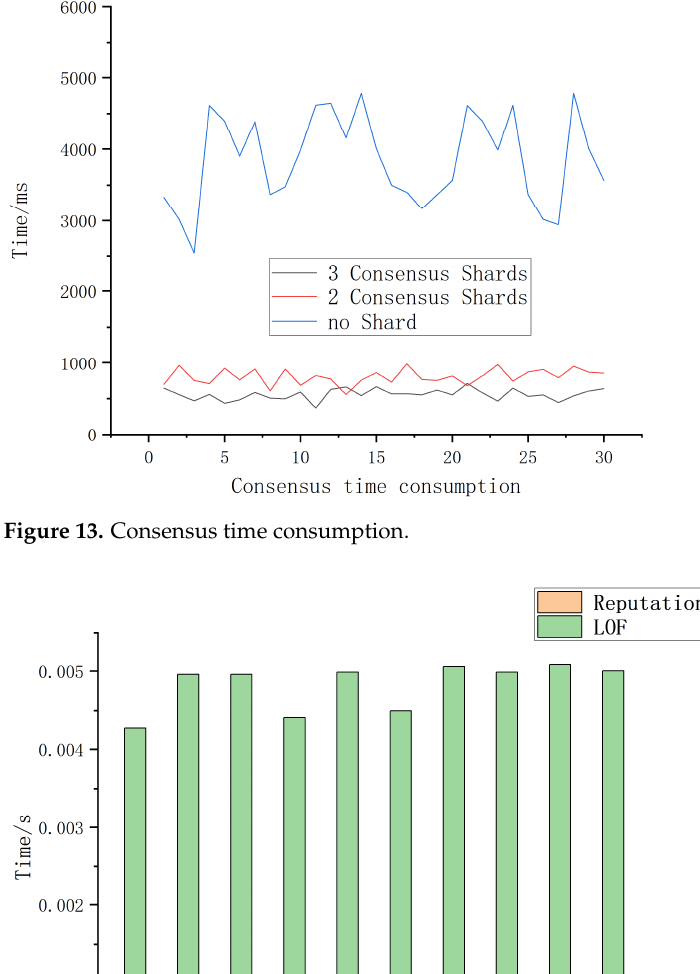
Figure 12. Consensus time consumption under four shards.